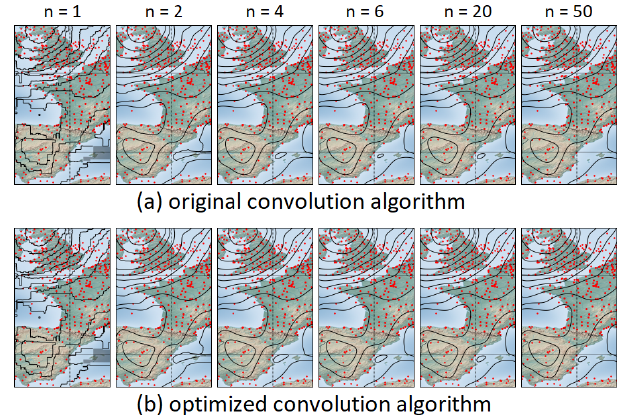
Figure 9. Results for a different number of performed convolutions n . Upper row (a) with results for the original convolution algorithm and lower row (b) with results for the optimized convolution algo-